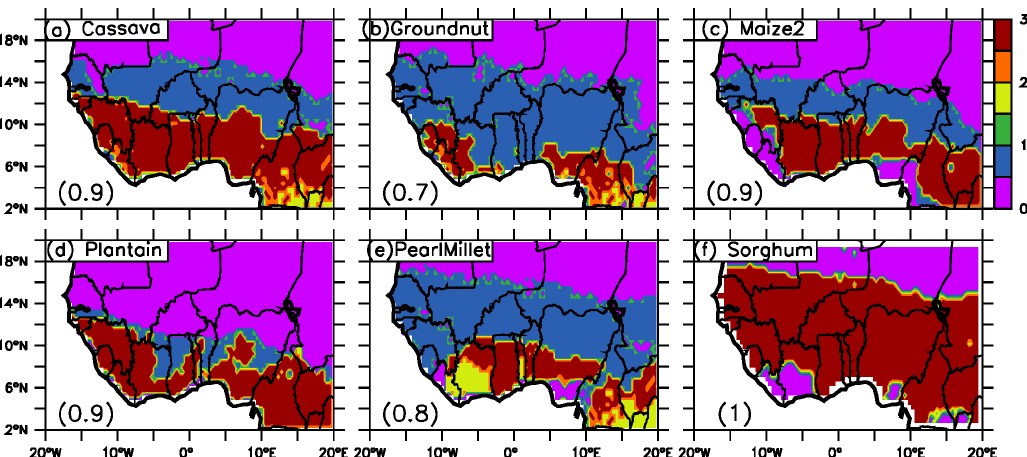
Figure 2. A simulated spatial distribution of the crop harvested area and suitability over West Africa for the year 2000 as simulated by the MIRCA2000 dataset and Ecocrop, respectively. The blue area (represented by 1) are the crop harvested area around the year 2000 as simulated by the MIRCA2000 dataset while the yellow colour represents the suitability index value above0.2 (SIV ≥ 0.2) which is represented by two. The red colour represents the area where the two datasets agree as denoted by three. The number at the left-hand corner represents the spatial correlation (r ≥ 0.7) value between the two datasets. The red colour depicts in Fig. 2a-2f depicts harvested and suitable areas as simulated by MIRCA2000 and Ecocrop from cassava to sorghum respectively. The blue colour depicts MIRCA2000 simulated harvested area only for each crop while yellow means Ecocrop simulated suitable areas for cultivation of each crop in year 2000. The purple colour, 0 depicts non harvested and unsuitable areas as simulated by both MIRCA2000 and Ecocrop for each of the crops around the year